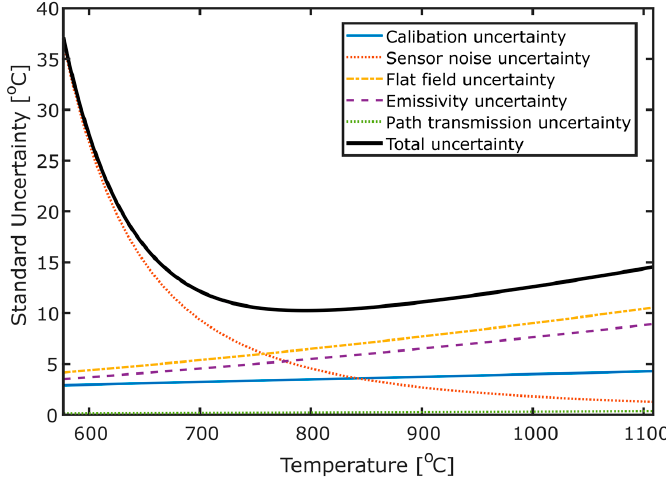
Figure 4. Calculated measurement uncertainties vs measured temperature for 1 ms exposure time on the PiCam. As in the discussion of Section 2.4, all uncertainties are for a 95% confidence interval. For